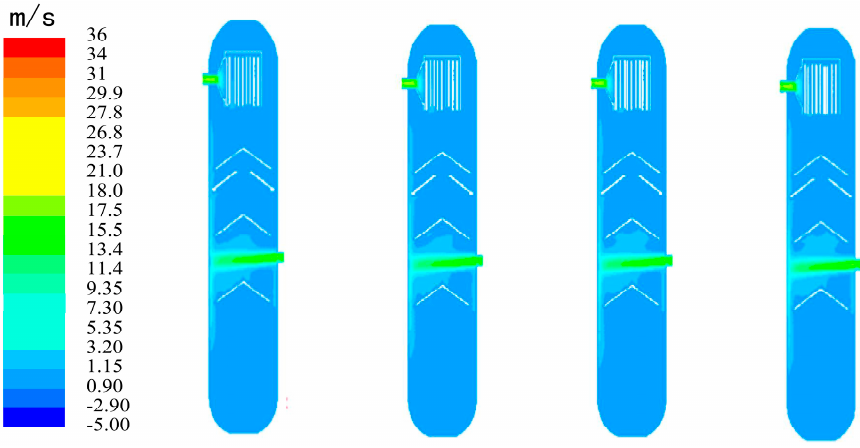
Figure 3. Velocity profile under different water volume percentages of different entrances.